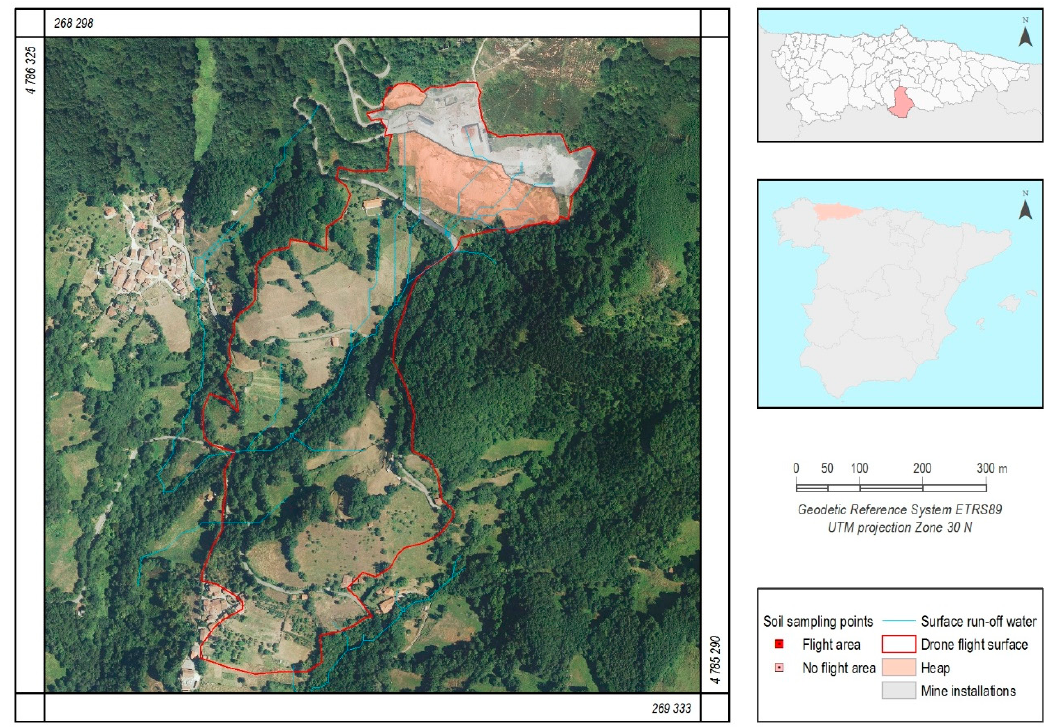
Figure 2. Location of the study area and sampling design.